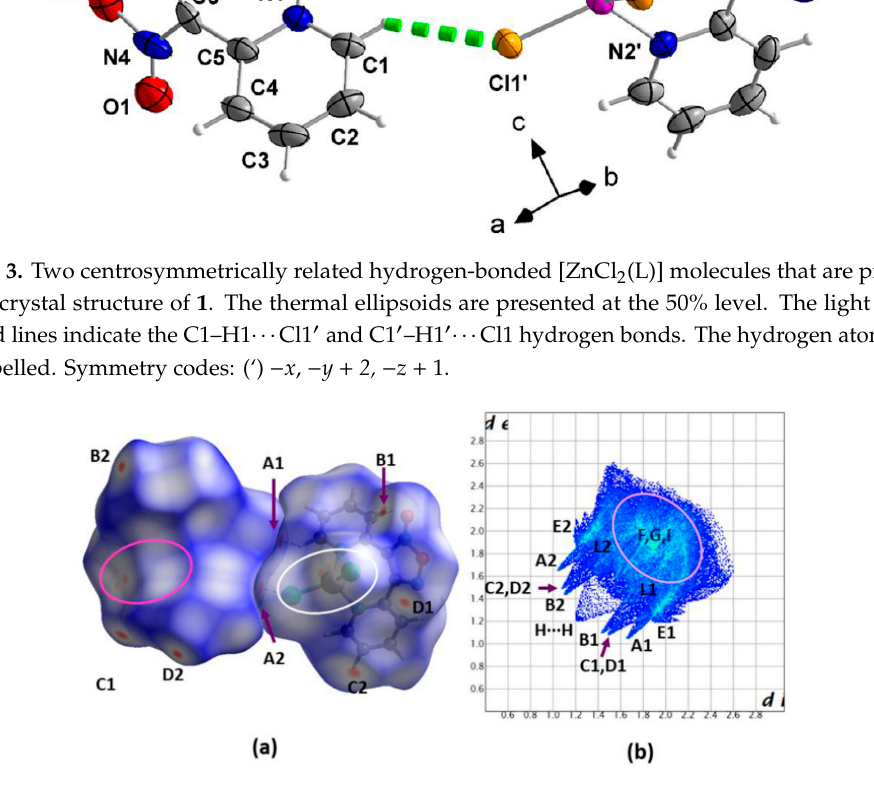
Figure 4. Hirshfeld surface (HS) analysis plots for complex [ZnCl 2 (L)] ( 1 ): ( a ) HS decorated with the d norm property. A1, B1, C1 and D1 points indicate the areas of the acceptor atoms and A2, B2, C2 and D2 the areas of the hydrogen atoms of the donors in the C1–H1 ⋯ Cl1 ′ , C10–H10-O ′′′ , C11–H11–O1 ii and C3–H3–N3 i hydrogen bonds, respectively. ( b ) Fingerprint (FP) plot for all types of interactions, with labels indicating the contribution of each type of interactions (see text for details).